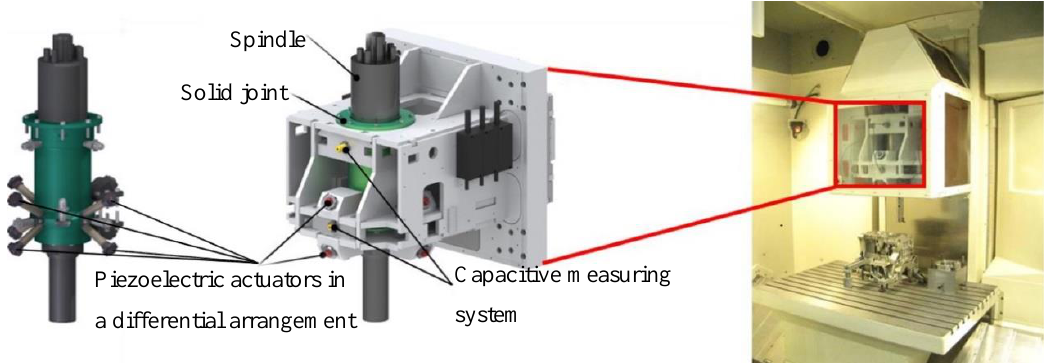
Figure 1. Construction of the piezo-kinematic system for the form (shape) drilling.